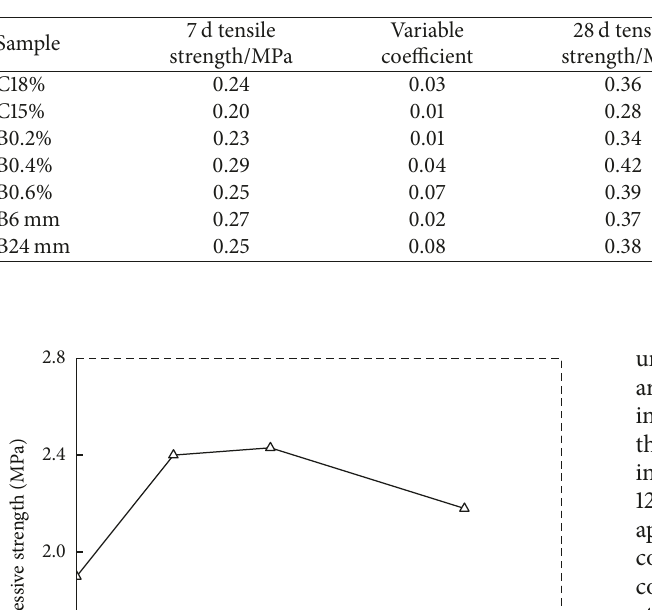
Table 6: The tensile strength of basalt fibre samples.